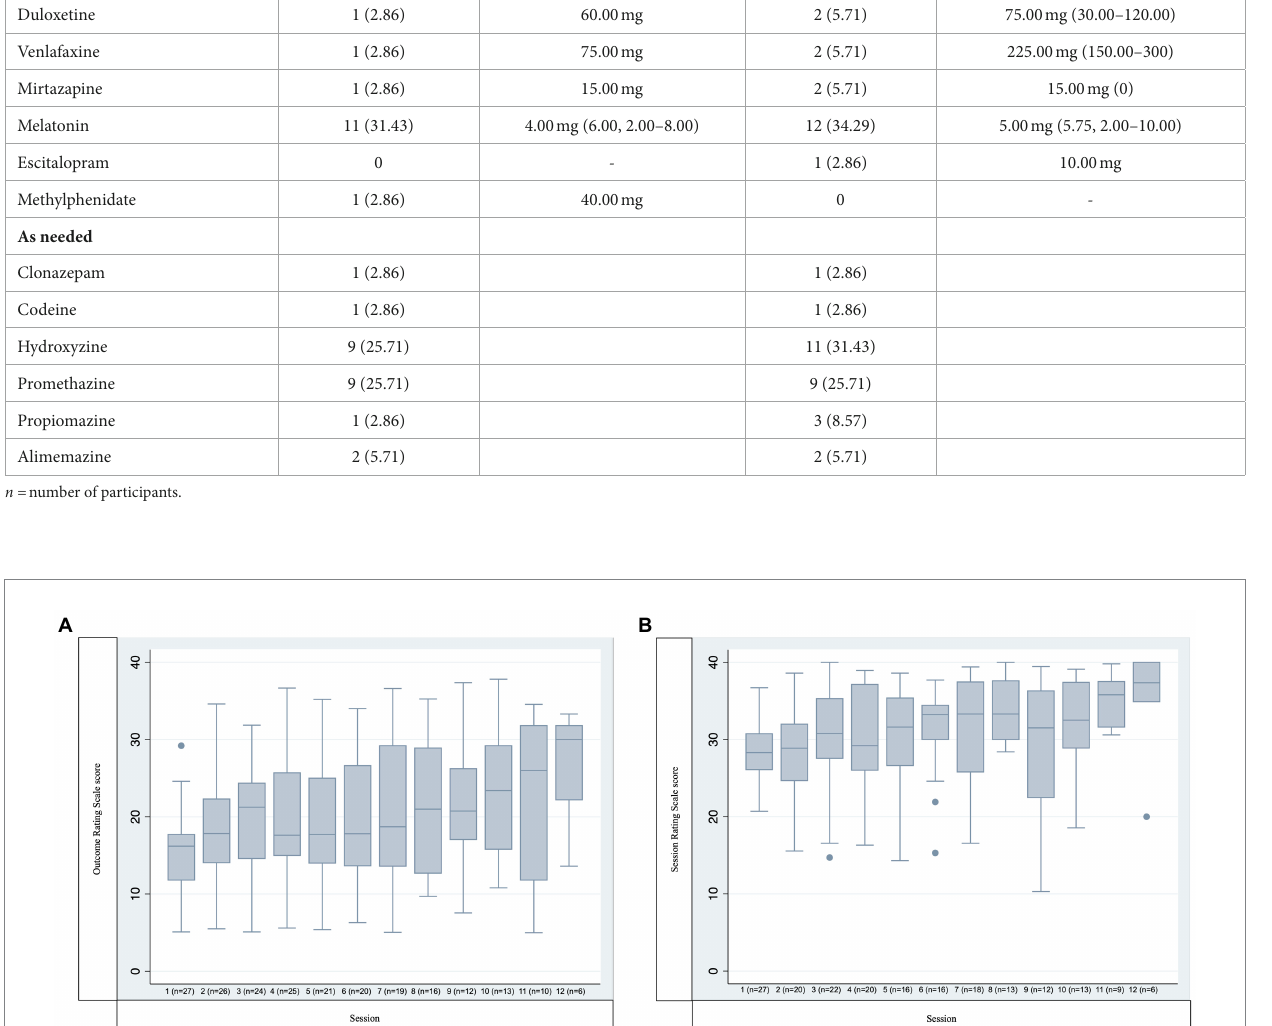
Dose at T0, Median n (%) (IQR, range)